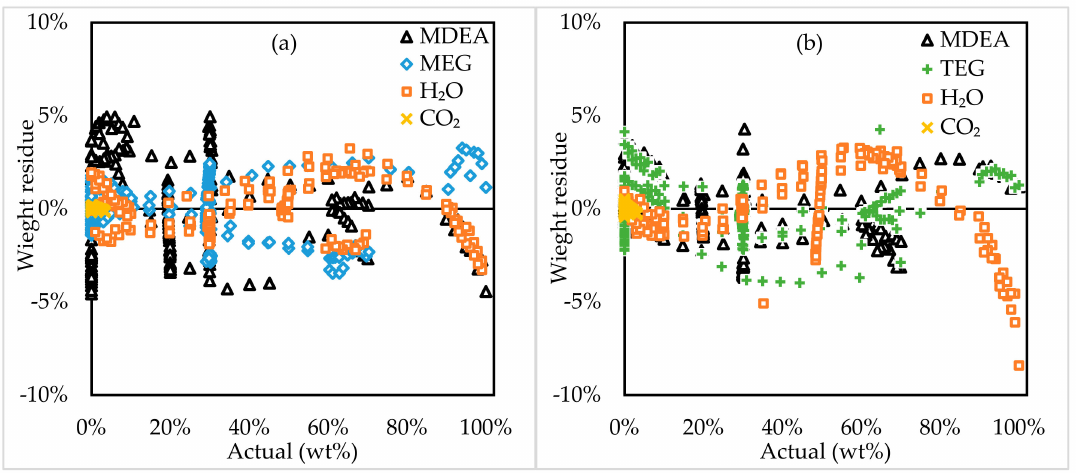
Figure 8. Weight residual of four-component systems; the MDEA-MEG-H 2 O-CO 2 system ( a ) and MDEA-TEG-H 2 O-CO 2 system ( b ).